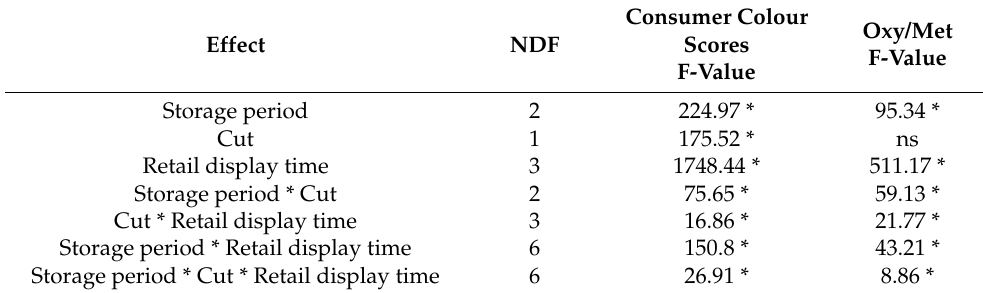
Table 2. F-values for the effects of the storage period, cut, and retail display time on consumer colour scores and oxy/met.